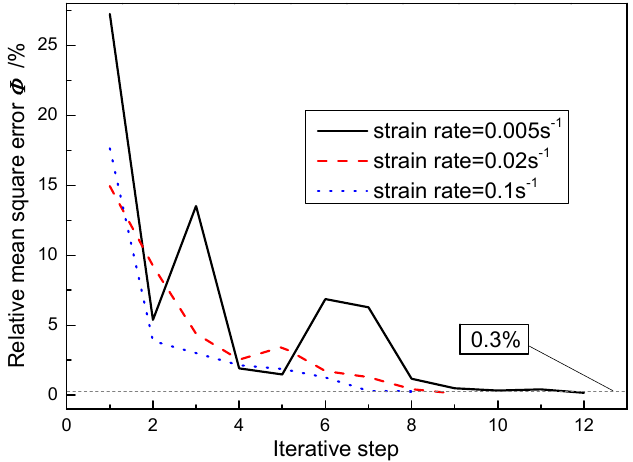
Figure 6. Relative mean square error Φ versus iterative step at different strain rates.